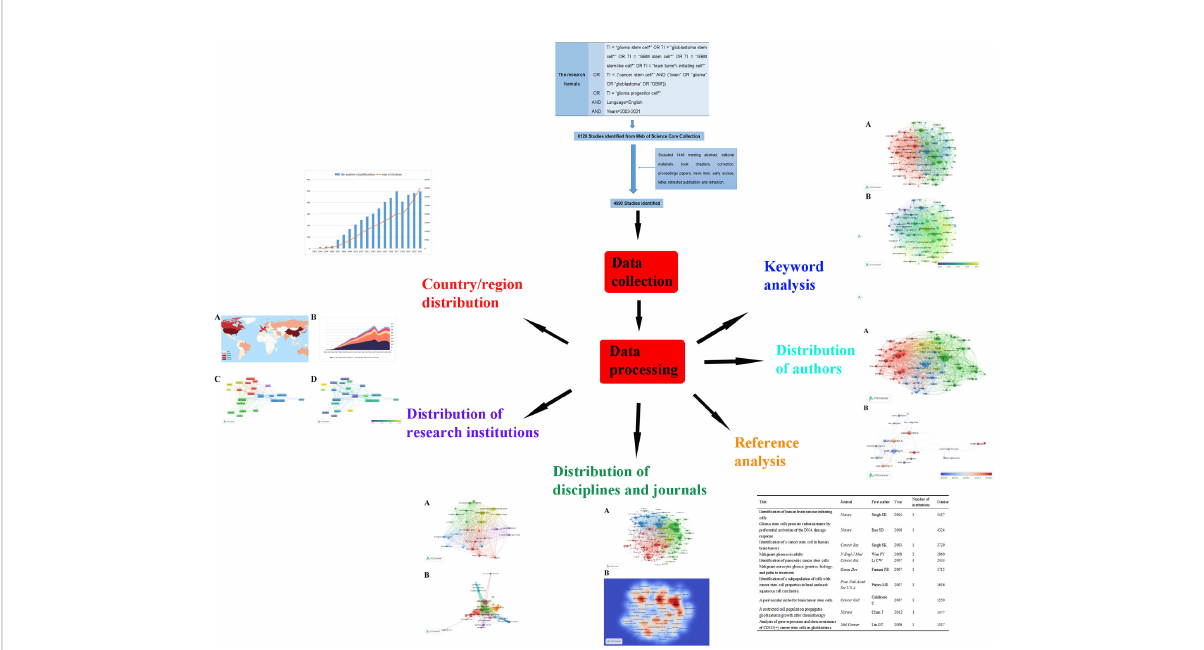
FIGURE 1 We searched the Web of Science Core Collection (WoSCC) on GSCs and performed a visualization analysis from the perspectives of countries, institutions, disciplines, journals, authors, references and keywords to predict future research hotspots in this fi